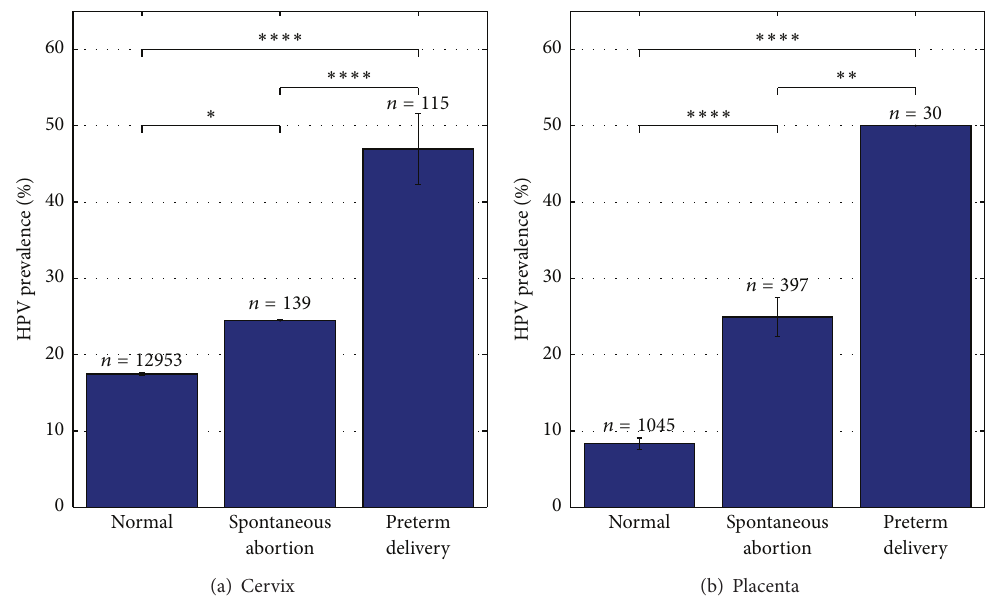
Figure 3: Higher HPV prevalence detected in pregnancies with adverse outcome compared to normal pregnancies. HPV prevalence in normal pregnancies, spontaneous abortions, and spontaneous preterm deliveries in %. (a) In cervix. 34 studies have been included in the present analysis, 𝑁 Normal = 32 , 𝑁 Spontaneous abortion = 1 , and 𝑁 Preterm delivery = 2 . (b) In placenta. 14 studies have been included in the present analysis, 𝑁 Normal = 9 , 𝑁 Spontaneous abortion = 6 , and 𝑁 Preterm delivery = 1 . 𝑁 indicated number of studies included. 𝑛 indicates number of cases included. ∗ 𝑃 < 0.05 , ∗∗ 𝑃 < 0.01 , and ∗∗∗∗ 𝑃 < 0.0001 .